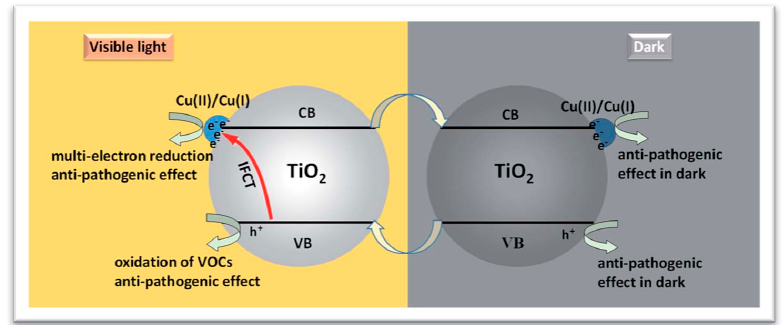
Figure 6. Proposed processes of photocatalysis and inactivation of viruses and bacteria under visible-light irradiation and dark conditions. Reprinted from [85] under CC BY-NC 3.0 license, 2009.